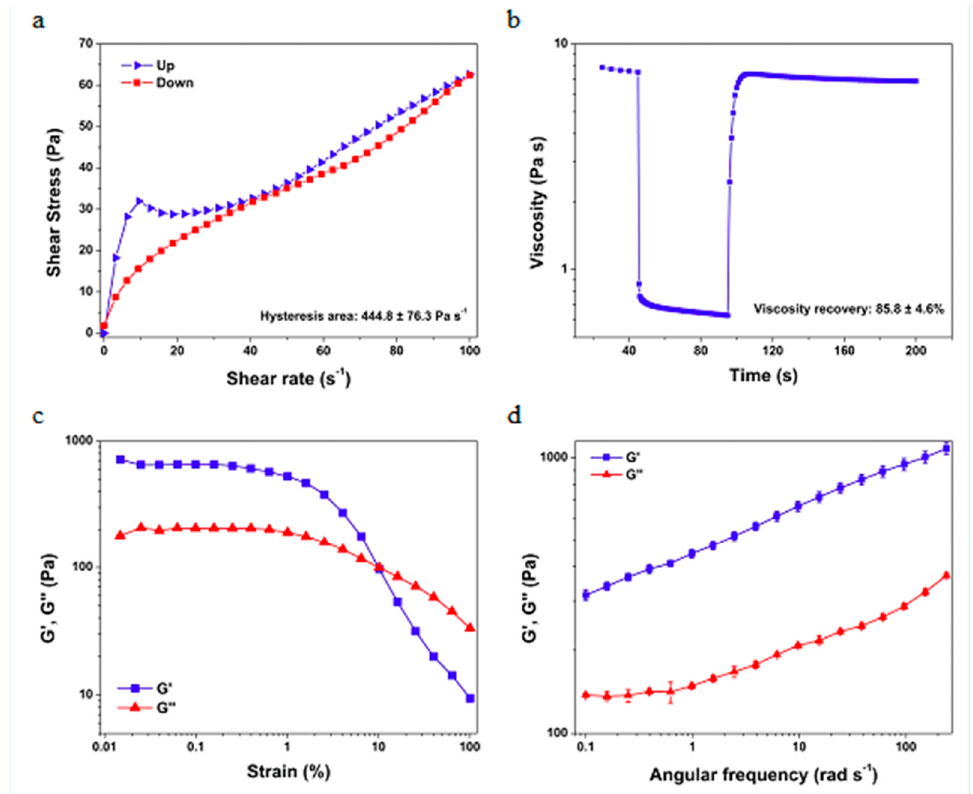
Figure 3. Rheograms of flow curve assay ( a ); fluency and relaxation assay using sheering tension of 7 Pa for 45 s for fluency, 70 Pa for 60 s for resting 7 Pa for 100 s for relaxation ( b ); amplitude and frequency sweep tests ( c , d ) of phytocosmetic.